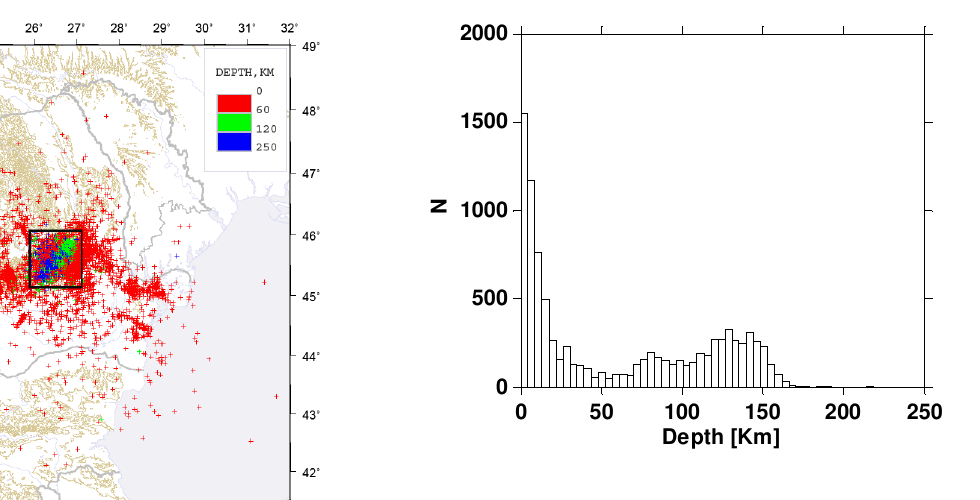
Fig. 2. Depth distribution of seismicity of